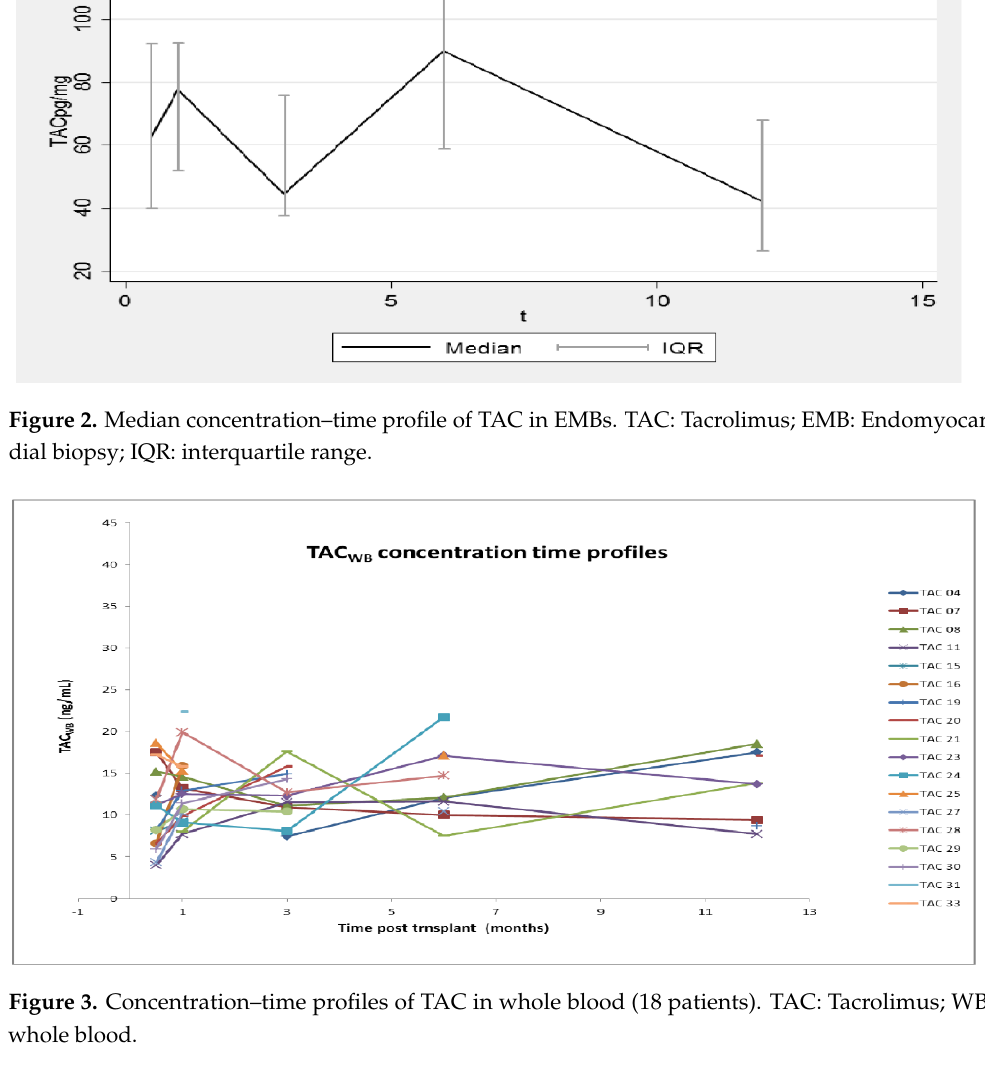
Figure 3. Concentration–time profiles of TAC in whole blood (18 patients). TAC: Tacrolimus; WB: whole blood.